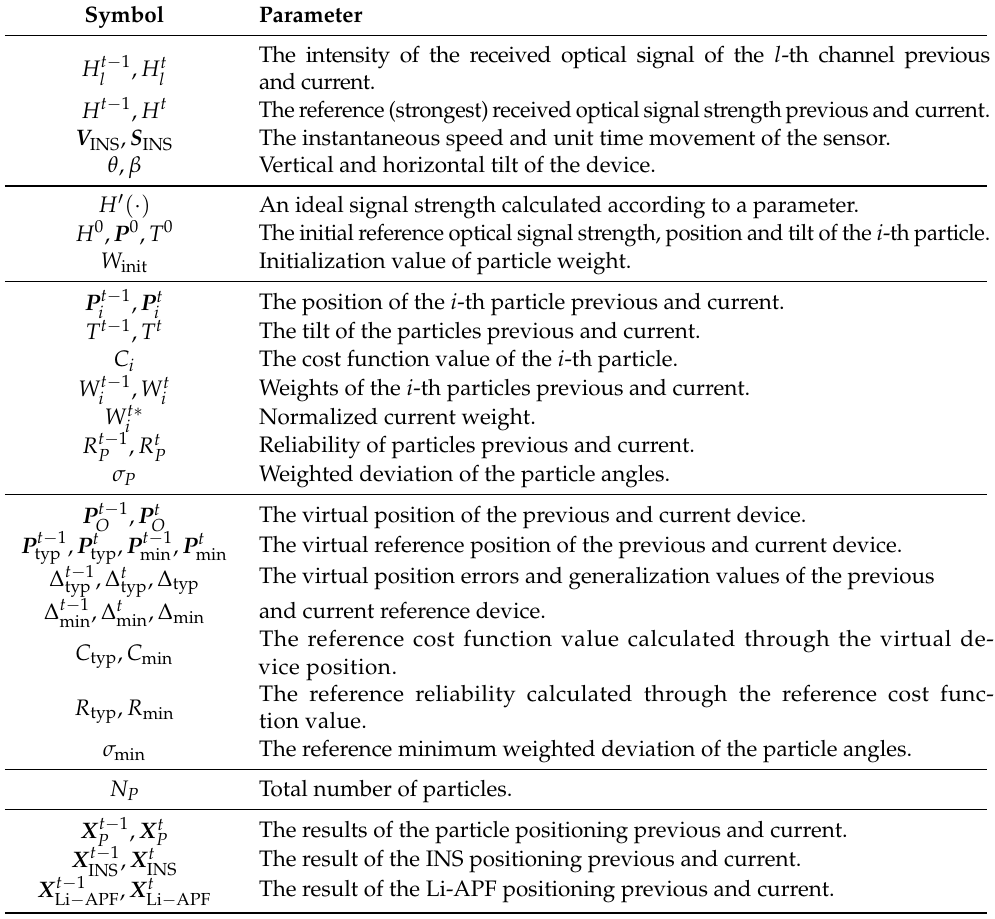
Table 1. Parameters of the proposed